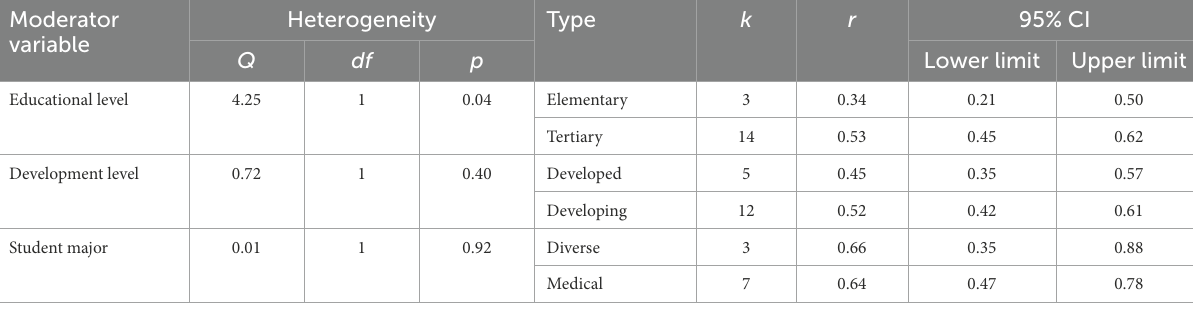
TABLE 7 Moderator analysis for the prevalence of depression.